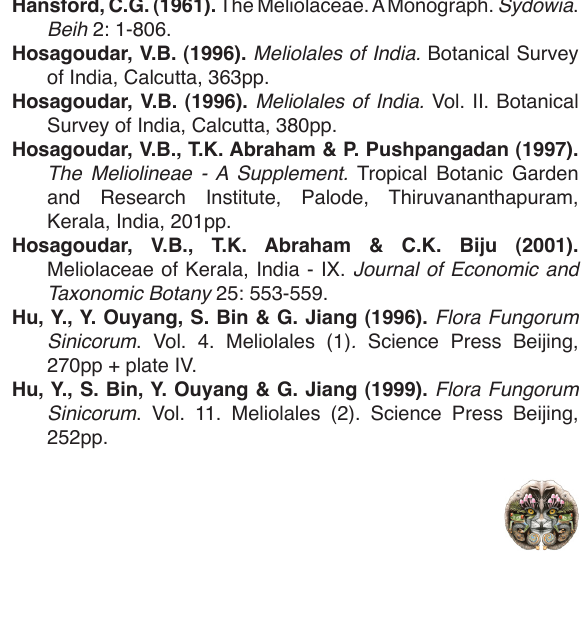
Figure 4. Meliola psophocarpi sp. nov. a - Appressorium; b - Phialide; c - Apical portion of the mycelial setae; d -